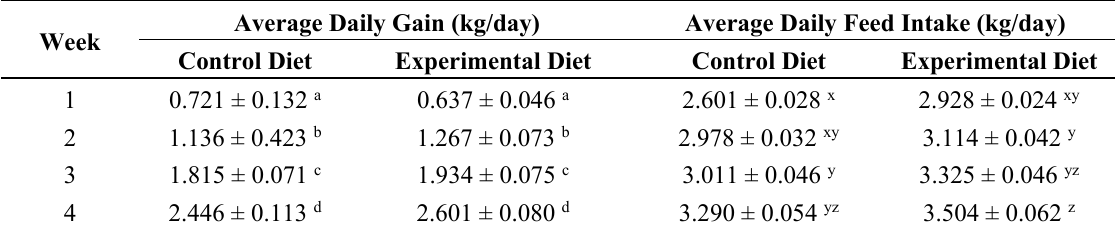
Table 3. Effect of diet on average daily gain and average daily feed intake.